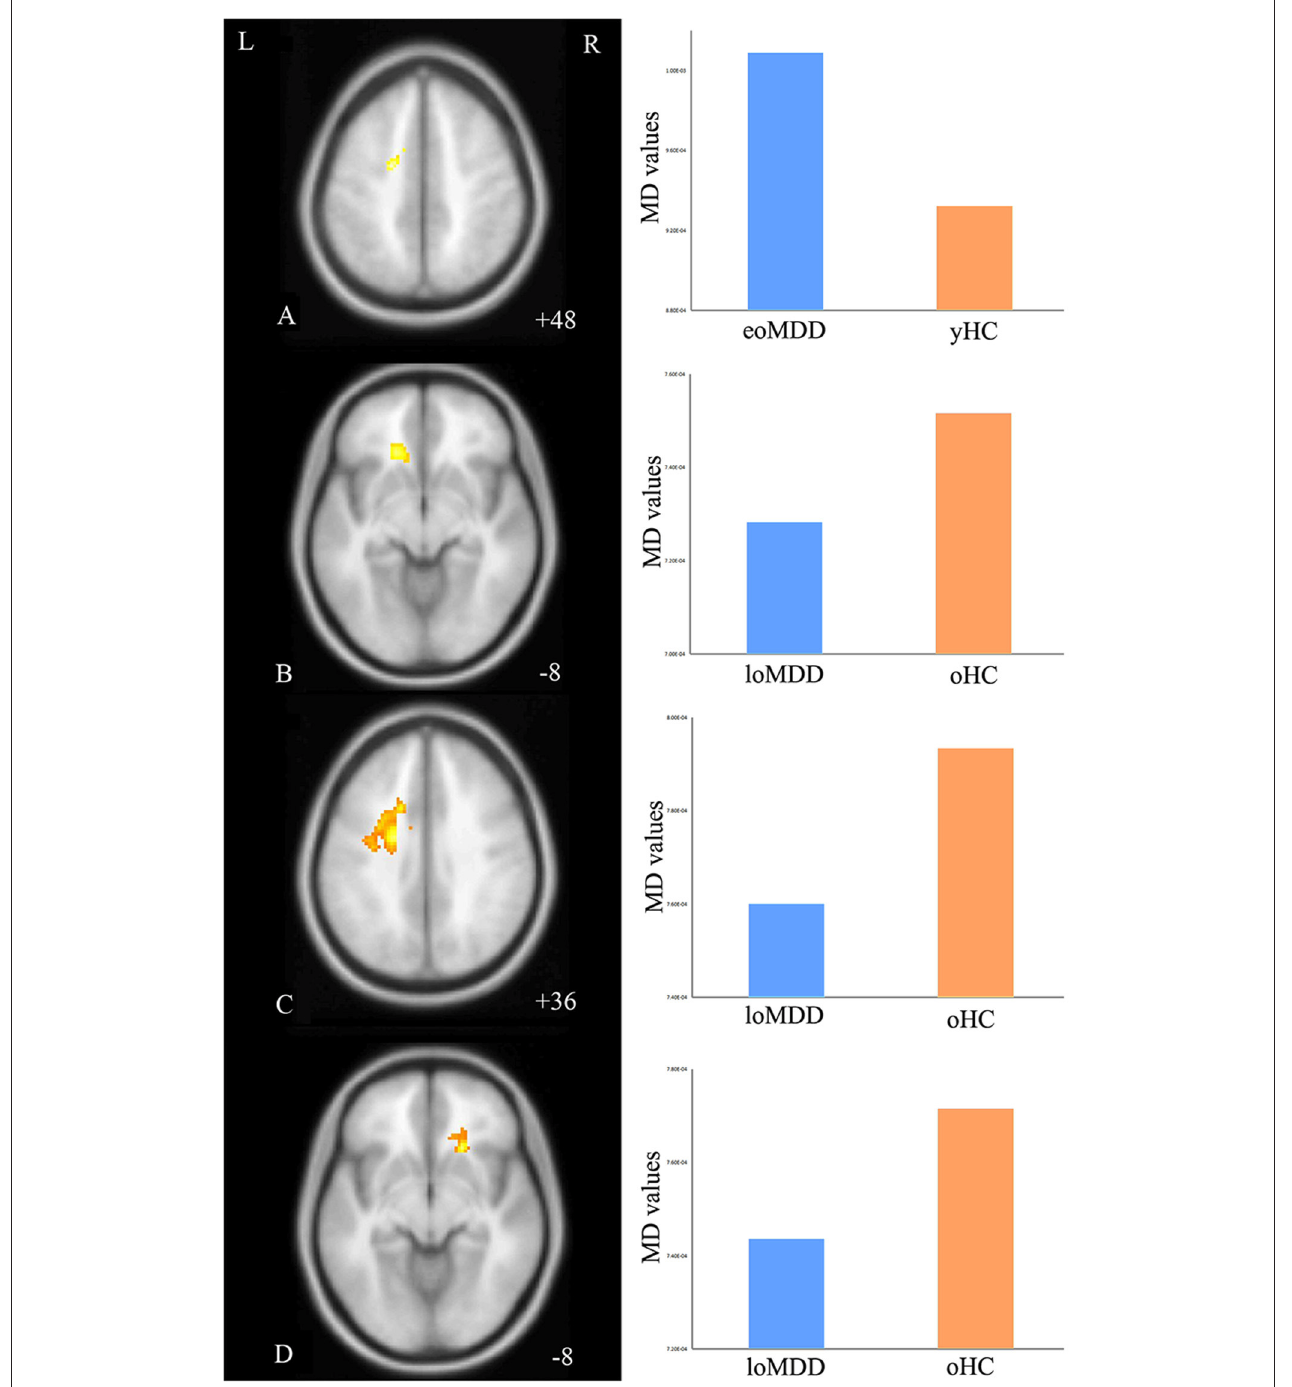
FIGURE 2 | Regions of differences for white matter integrity between medication-naïve patients with major depressive disorder (MDD: eoMDD, onset age ≤ 25 years old; loMDD, onset age > 25 years old) and healthy controls (HC: yHC, younger healthy controls; oHC, older healthy controls). (A) The axial image ( z = + 48mm) shows the significantly increased mean diffusivity (MD) values in the left inferior fronto-occipital fasciculus (IFOF) with eoMDD, compared to yHC. (B) The axial image ( z = − 8mm) shows the significantly decreased MD values in the left IFOF with loMDD, compared to oHC. (C) The axial image ( z = + 36mm) shows the significantly decreased MD values in the left IFOF with loMDD, compared to oHC. (D) The axial image ( z = − 8mm) shows the significantly decreased MD values in the right IFOF with loMDD, compared to oHC. The graph shows MD values for eoMDD, yHC, loMDD, and oHC.